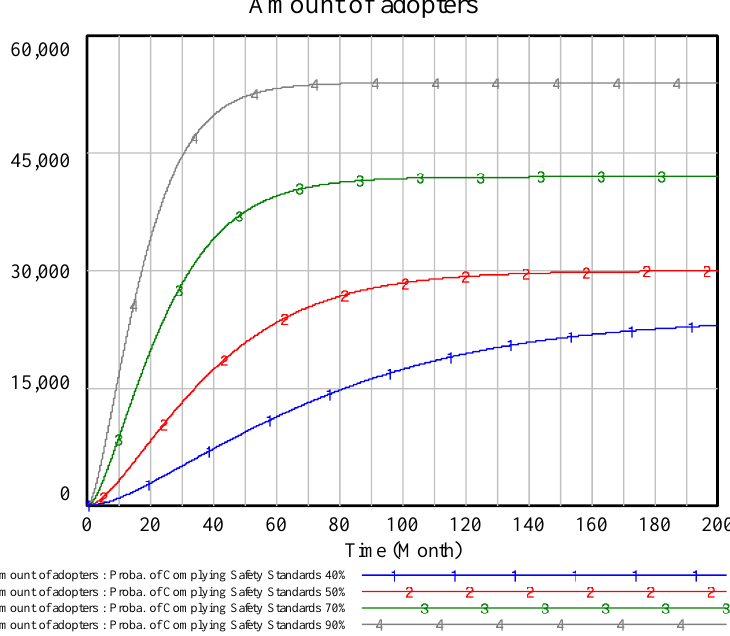
Figure 7. Sensitivity of probability of complying with safety standards on number of adopters.